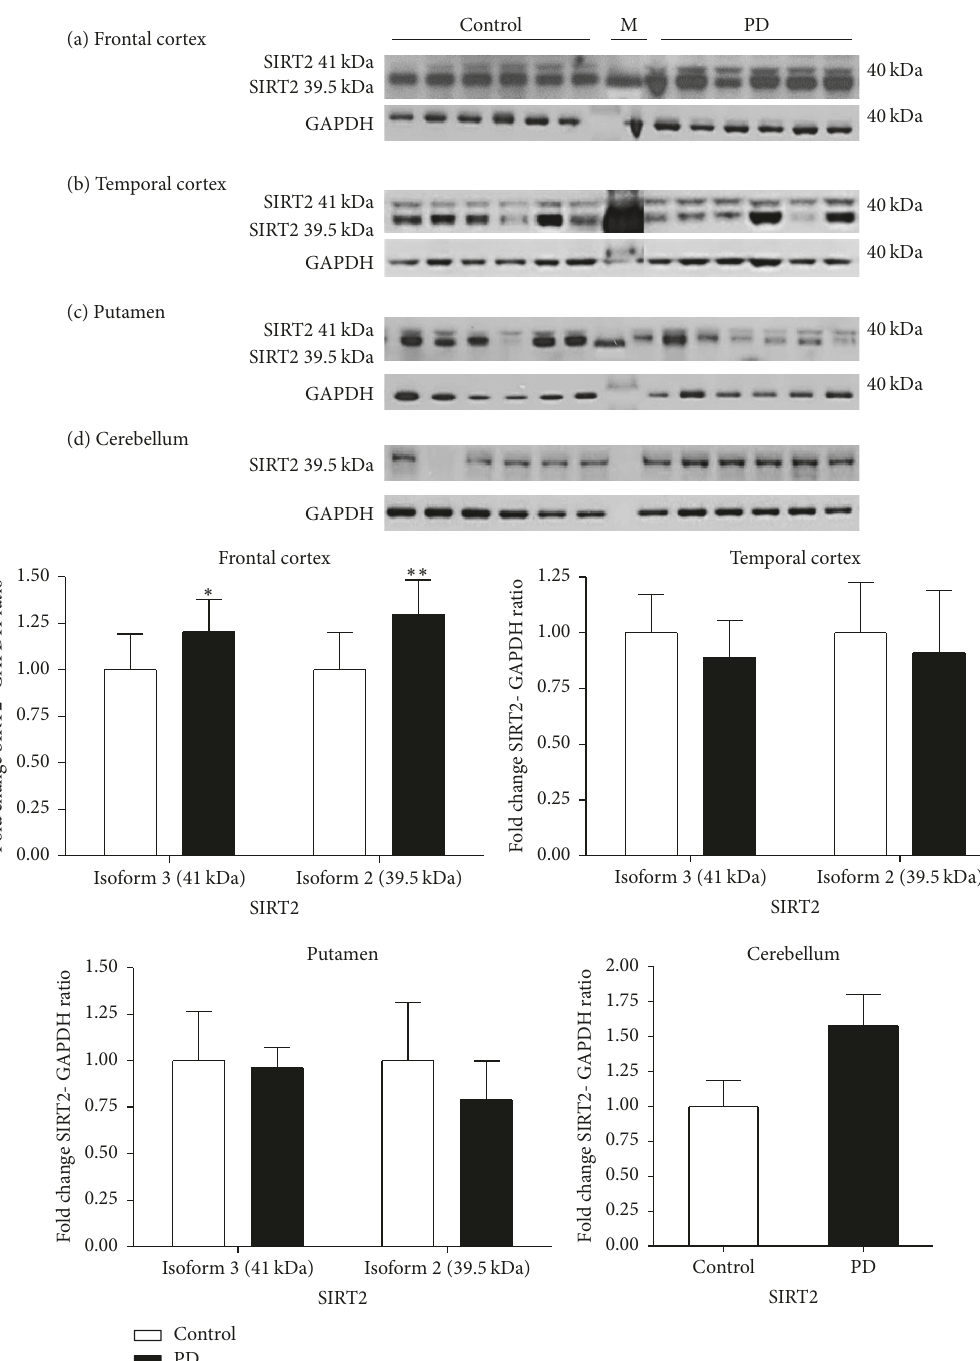
Figure 6: Expression of SIRT2 in different brain regions in Parkinson’s disease. The levels of SIRT2 were determined in different regions of PD patients and were compared to a control-cohort. SIRT2 band intensity was normalised with GAPDH. Data are presented as fold change ( ± SD) with respect to control from three independent replicates. ∗∗ 𝑝 < 0.01 , and ∗ 𝑝 < 0.05 when compared to control; statistical analysis was done through 𝑡 -test performed on GraphPad prism. Images are representative blots of SIRT2 and GAPDH. M indicates molecular weight markers